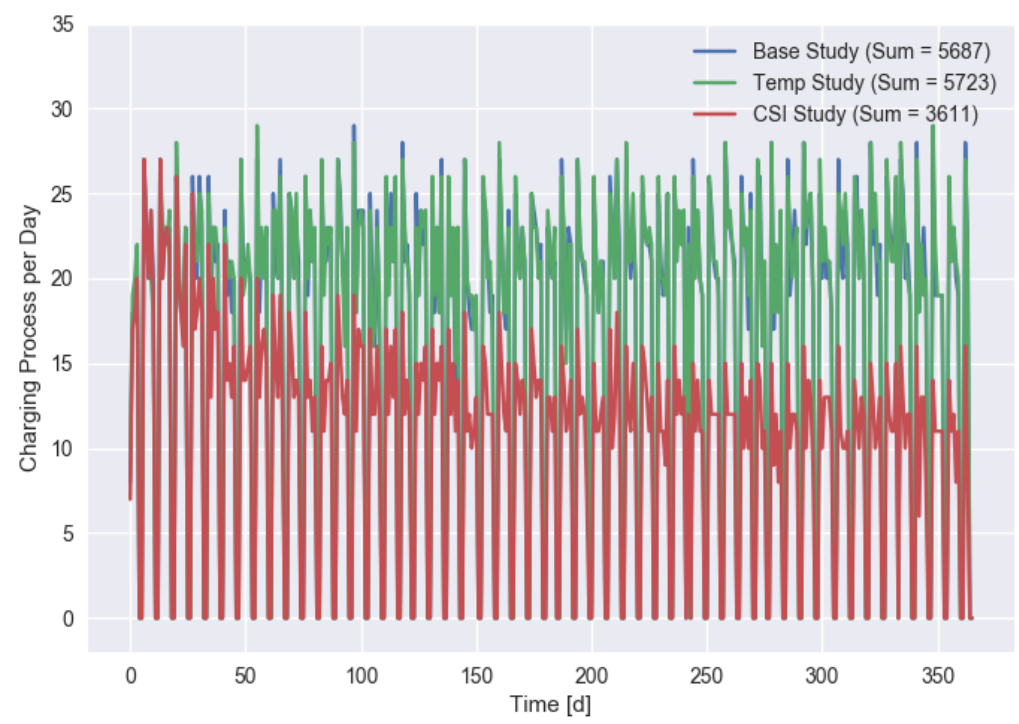
Figure 7. Number of daily charging processes for different